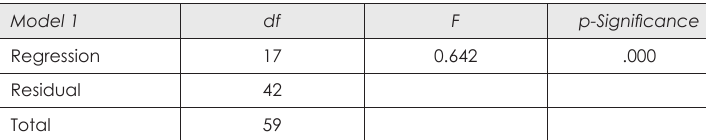
Model 1 ANOVA test results